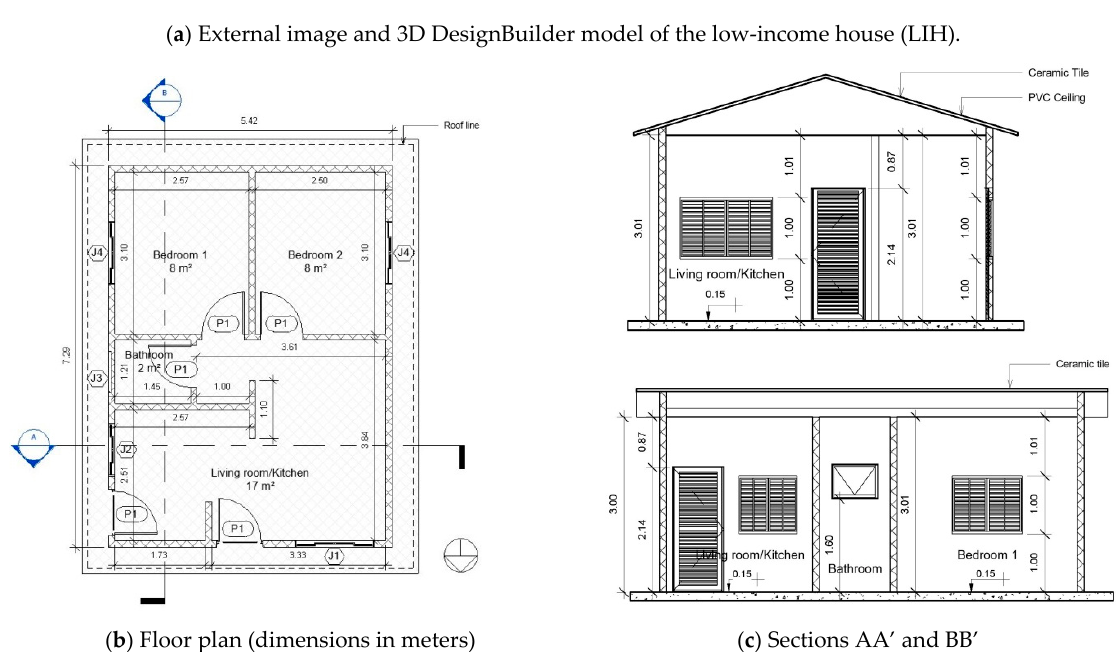
Figure 2. ( a ) Standard low-income housing picture, ( b ) floor plan, and ( c ) section plans.